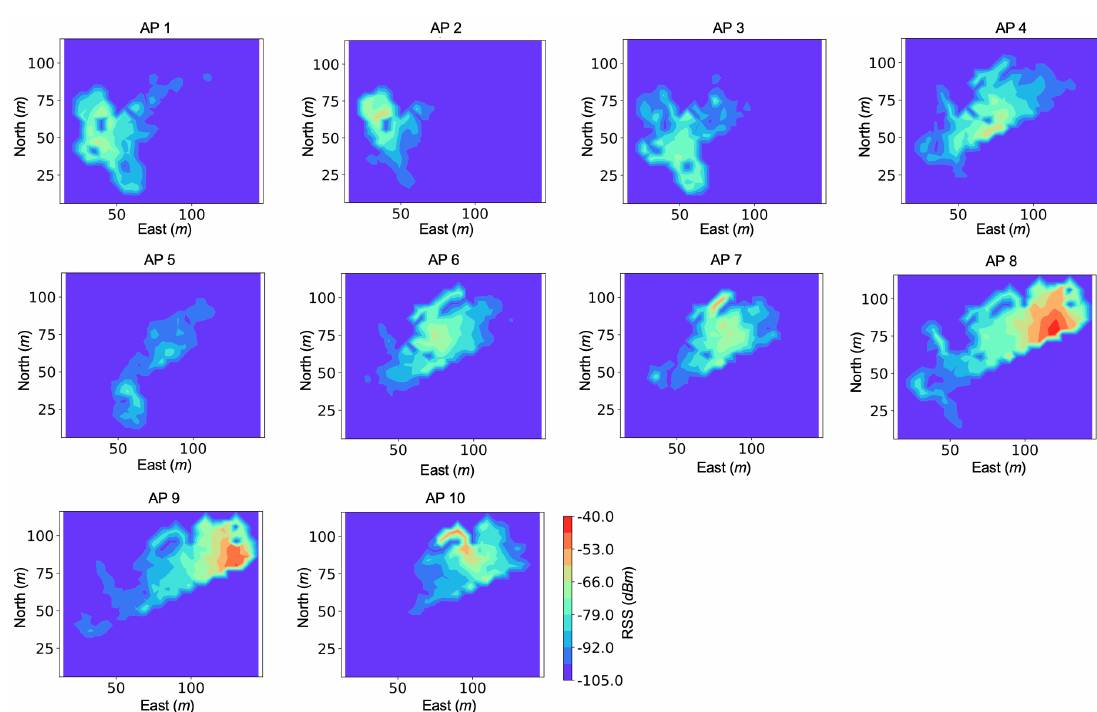
Figure 6. WiFi RSS distributions within test